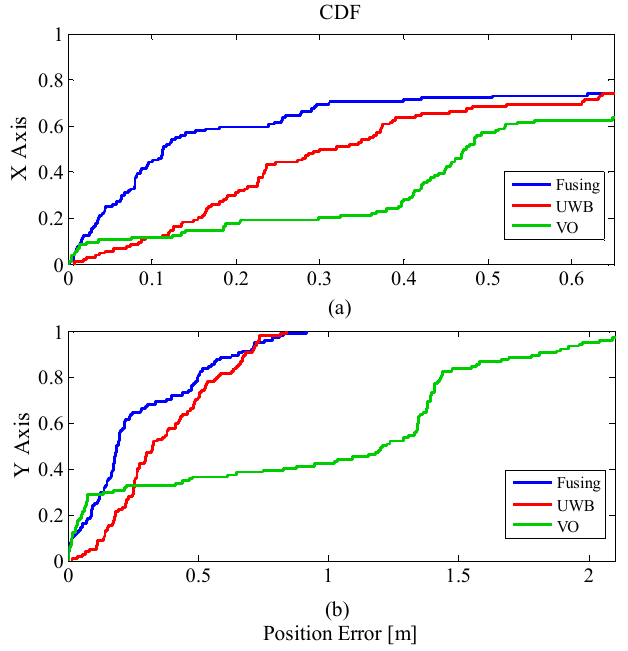
Figure 15. Position error, cumulative distribution function.